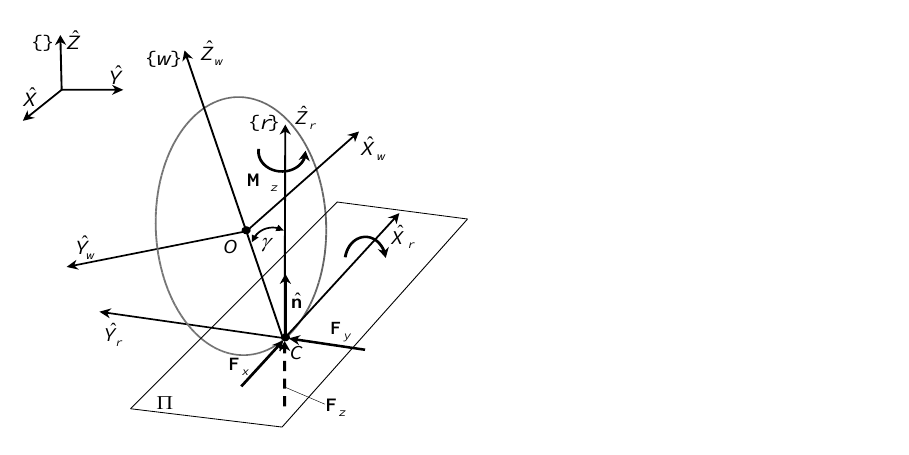
Figure 14. Road surface reaction forces: F x —longitudinal force (rolling resistance), F y —lateral force, M z —aligning torque.